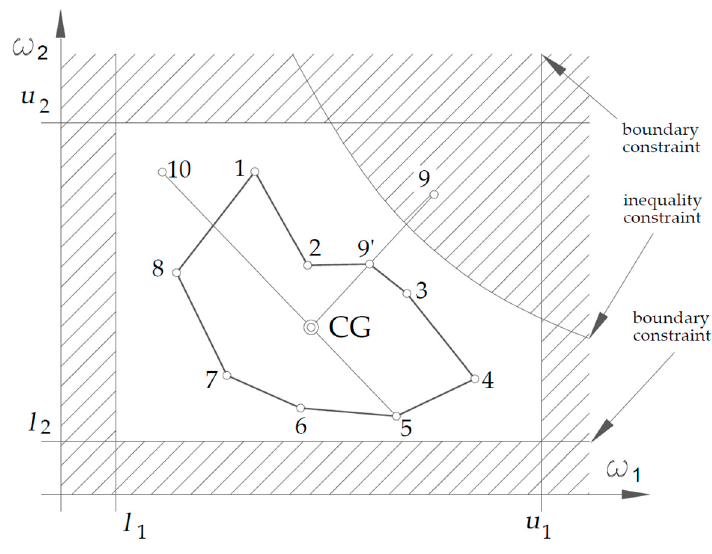
Figure A1. Scheme of the optimization procedure.